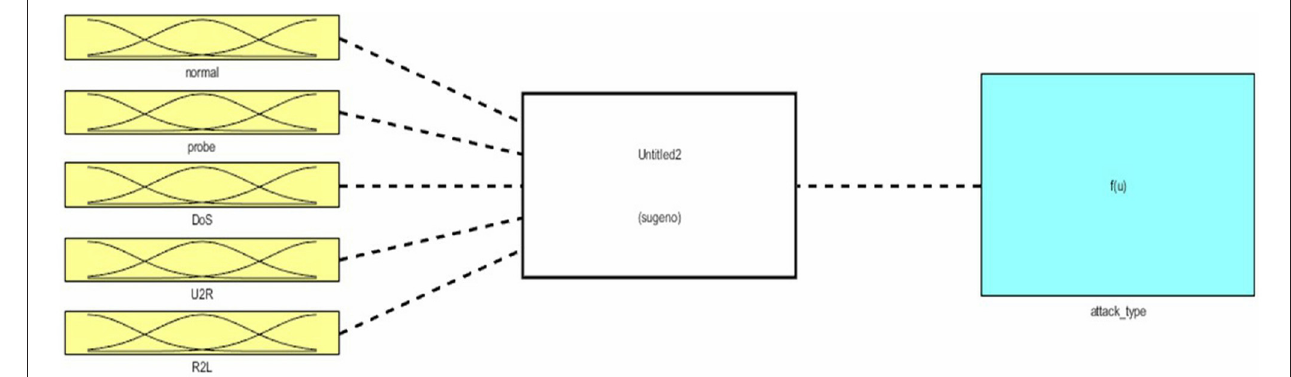
FIGURE 4 | Input parameters.